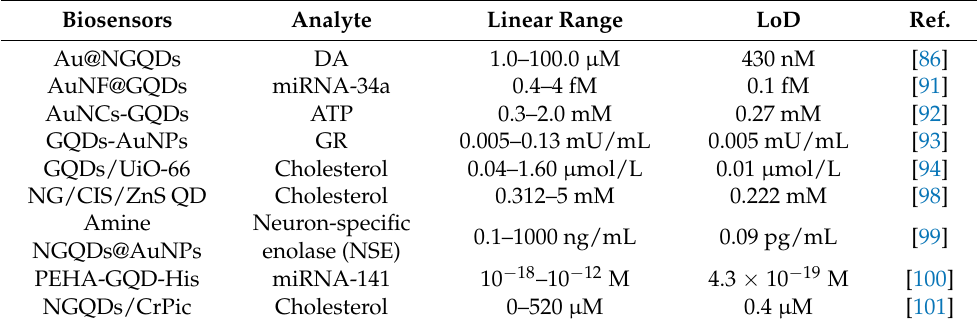
Table 2. Summary of the GQD nanocomposites for PL-based biosensing applications. Biosensors Analyte Linear